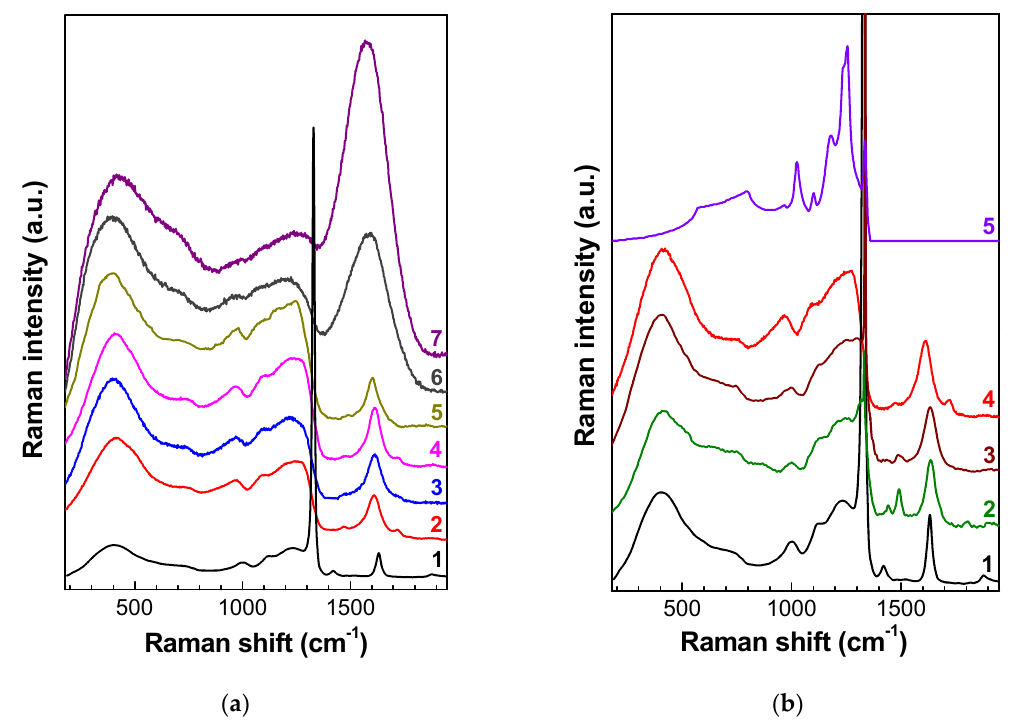
Figure 1. ( a ) Raman spectra of chemical vapor deposition (CVD) diamonds irradiated by fast neutrons: fluences of 3 × 10 18 cm −2 (1), 1 × 10 19 cm −2 (2), 2 × 10 19 cm −2 (3), and 2 × 10 20 cm −2 (5). Raman spectrum of natural diamonds with a neutron fluence of 10 20 cm –2 (4) and 3 × 10 20 cm –2 (6 and 7). Spectrum (1) is recorded with excitation at 532 nm; (3) and (5), with excitation at 488 nm; and other spectra, with excitation at 473 nm. The spectra are vertically shifted for clarity. ( b ) Raman spectra of CVD diamonds irradiated by neutrons 3 × 10 18 cm −2 ( 1 ) and 1 × 10 19 cm −2 (4) and of natural diamond implanted with 335 MeV nickel ions in the region with calculated vacancy concentrations of 4.3 × 10 21 cm −3 (2) and 1.1 × 10 22 cm −3 (3) [14]. (5) The density of phonon states in diamond [19].